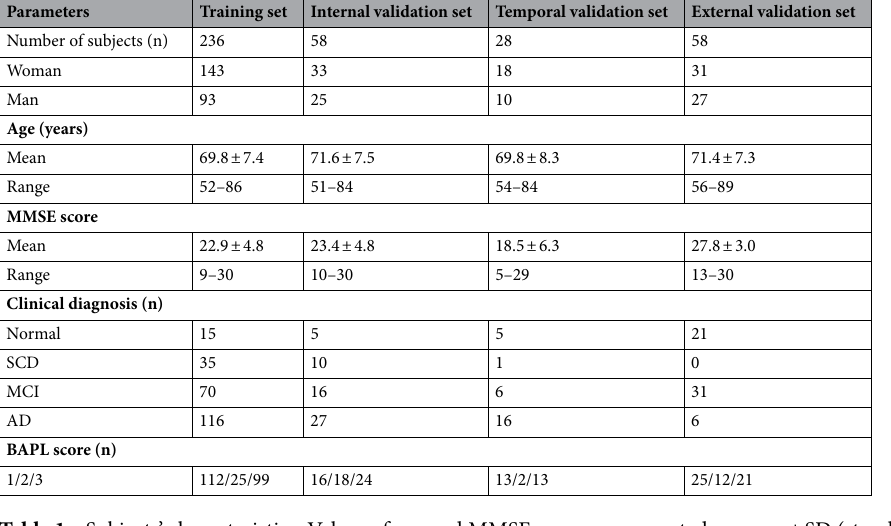
Table 1. Subjects’ characteristics. Values of age and MMSE score are presented as mean ± SD (standard deviation). AD Alzheimer’s disease, BAPL brain amyloid plaque load, MMSE mini-mental state